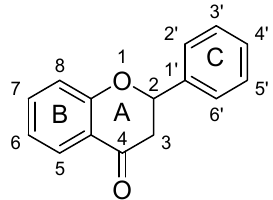
Figure 37. SAR of Flavanones. Figure 37. SAR of